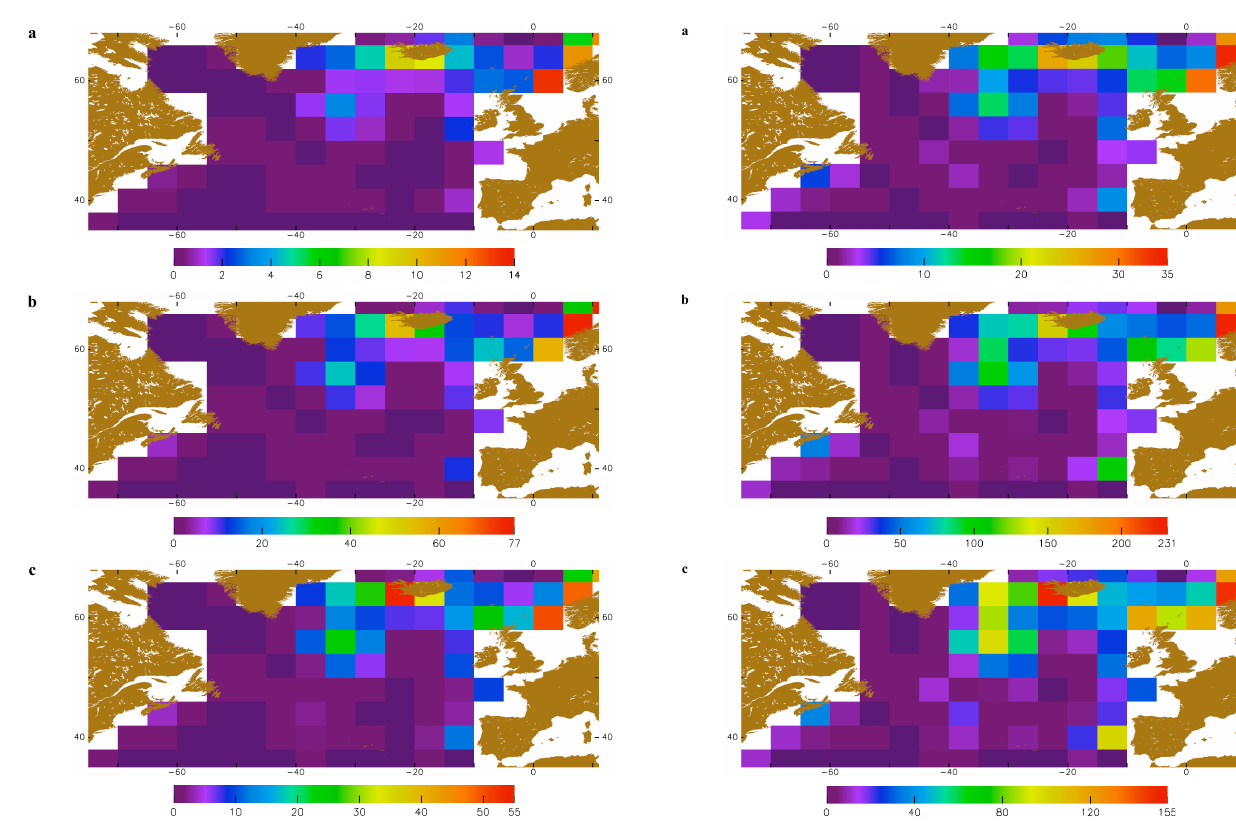
Figure 3 Spatial distribution of the average impact of Emiliania huxleyi on the monthly Fig. 3. Spatial distribution of the average impact of Emiliania hux- air-sea CO 2 flux for years 1998-2007. a) Percentage increase in seawater partial pressure p CO 2 (0-14%); b) Percentage decrease in air-water partial pressure difference Δ p CO 2 (0- leyi on the monthly air-sea CO 2 flux for years 1998–2007. (a) Per- 77%); c) Percentage decrease in air-sea CO 2 flux (0-55%). centage increase in seawater partial pressure p CO 2 (0–14%); (b) Percentage decrease in air-water partial pressure difference 1p CO 2 (0–77%); (c) Percentage decrease in air-sea CO 2 flux (0–55%).